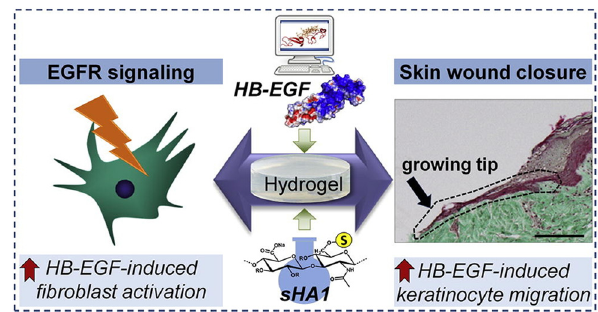
Figure 6: Schematic diagram of HE - EGF - combined hyaluronan/col - lagen hydrogels as wound dressings for wound healing [ 143 ]